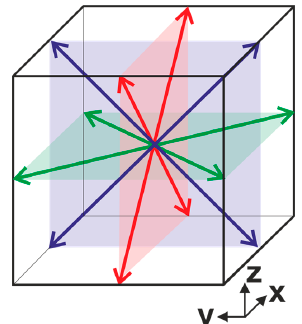
Figure 10. The schematic diagram of KNN crystal structure and possible directions of the spontaneous polarization.